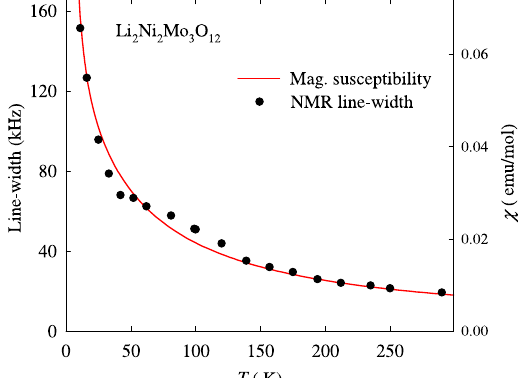
Figure 6. The variation of magnetic susceptibility and NMR line-width as a function of temperature for Li 2 Ni 2 Mo 3 O 12